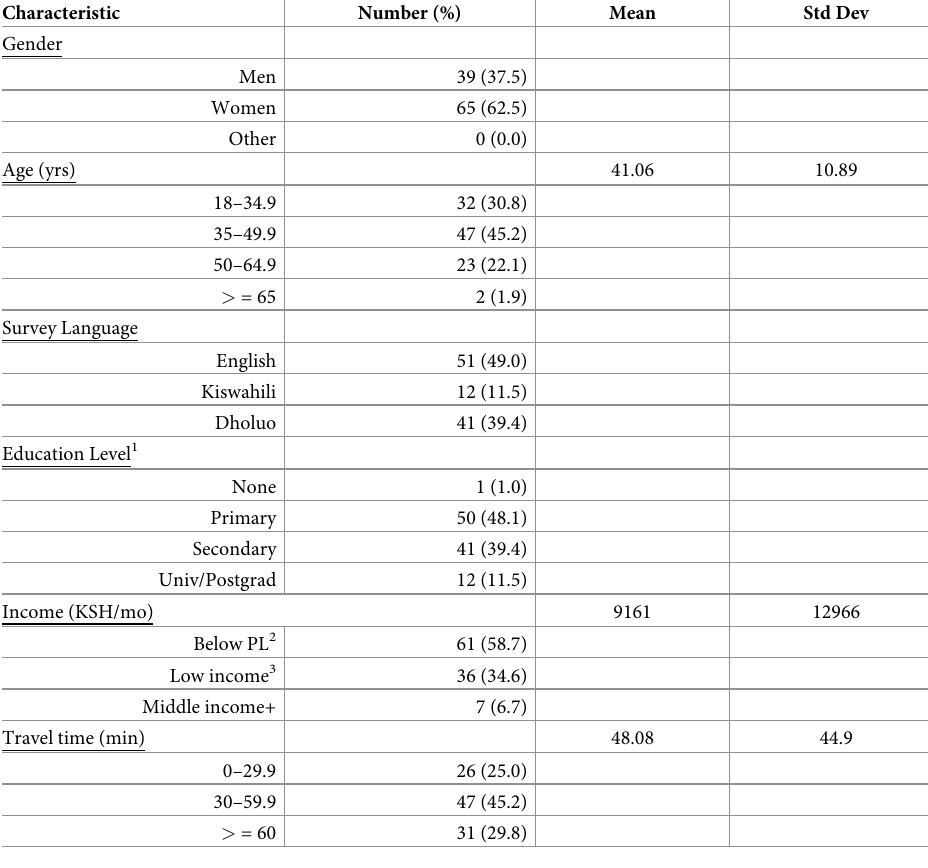
Table 3. Sociodemographic characteristics of HIV-infected patients (n =